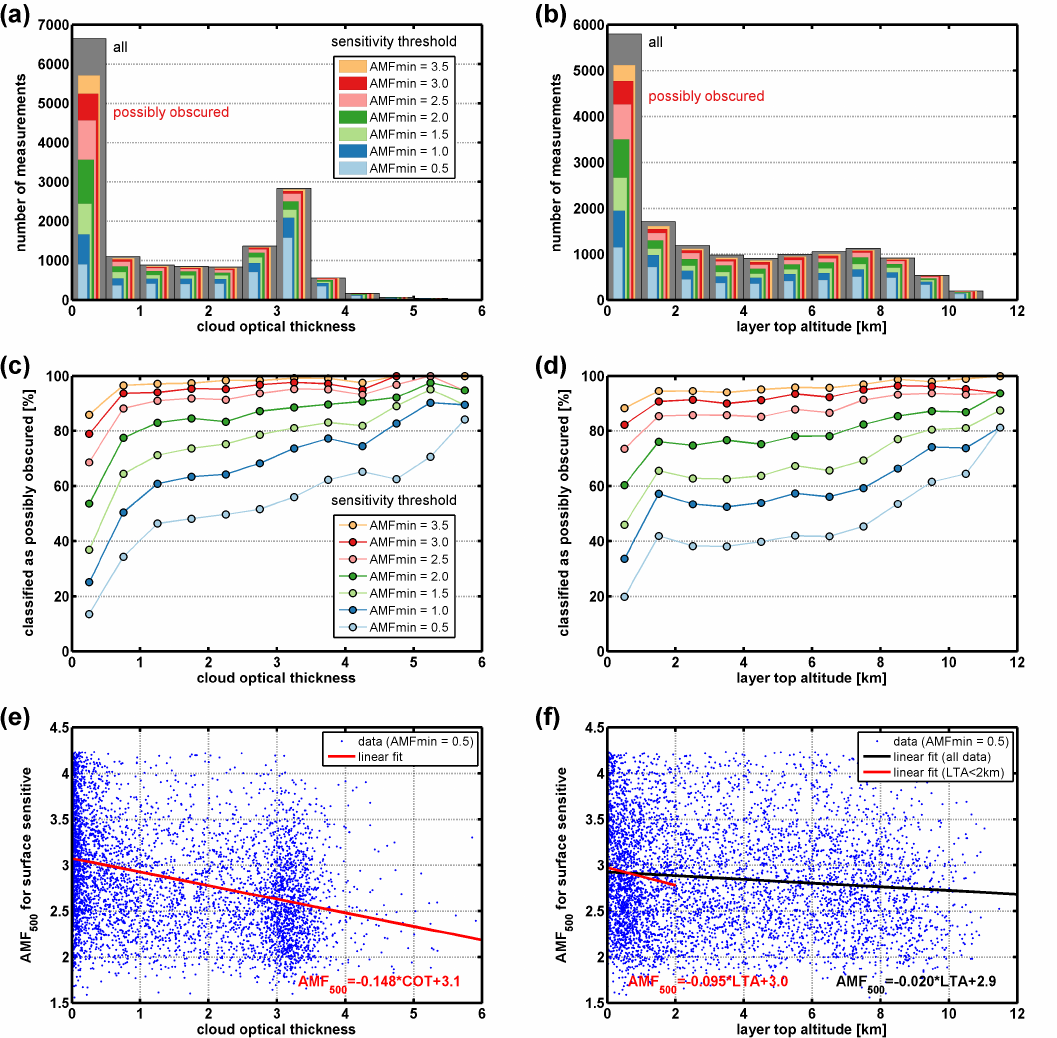
Fig. 12. Comparison between results of the surface sensitivity filter and collocated CALIPSO measurements over sea ice: CALIPSO cloud optical thickness (COT, left column) and CALIPSO layer top altitude (LTA, right column). (a) and (b) histograms of the unfiltered measure- ments compared to the histograms of measurements identified as possibly obscured at different sensitivity thresholds AMF min ratio of filtered measurements depending on COT and LTA, respectively; (e) and (f) respective dependence of A 500 for AMF min